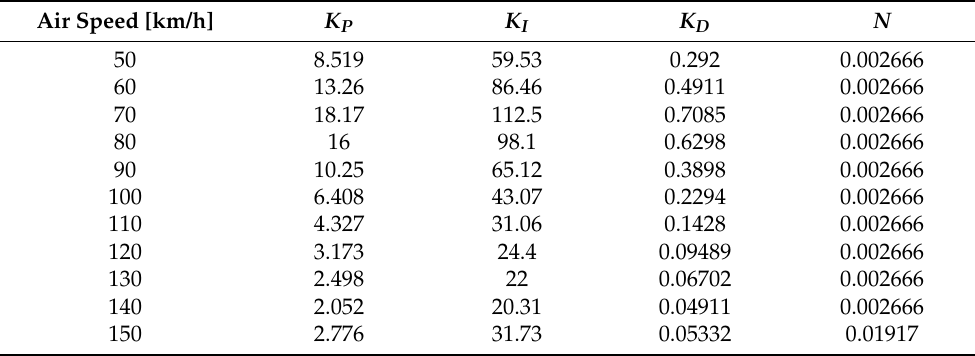
Table 3. PID controller coefficients for individual